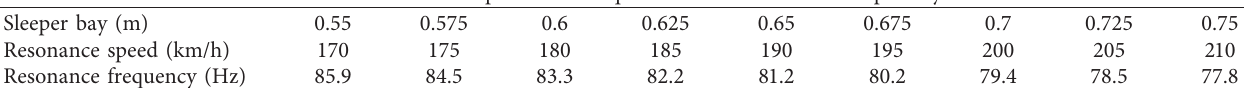
Figure 15: Axle box acceleration considering different parameters: (a) sleeper bay; (b) axle load; (c) vertical damping of primary suspension. Table 3: Resonance speeds and frequencies under different sleeper